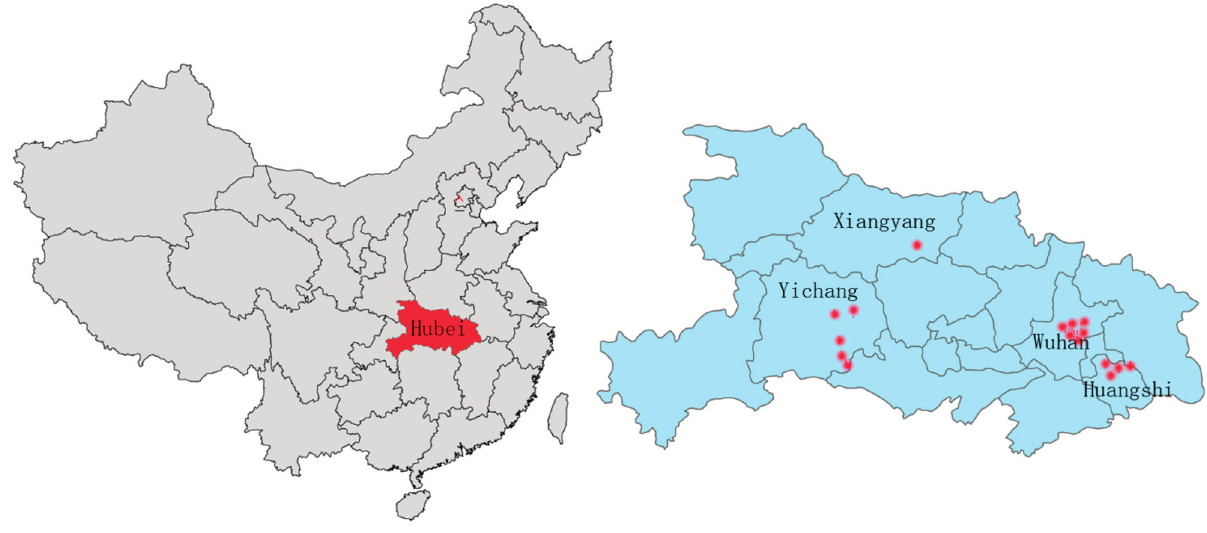
Figure 1. The location of Hubei in China and locations of monitoring sites in